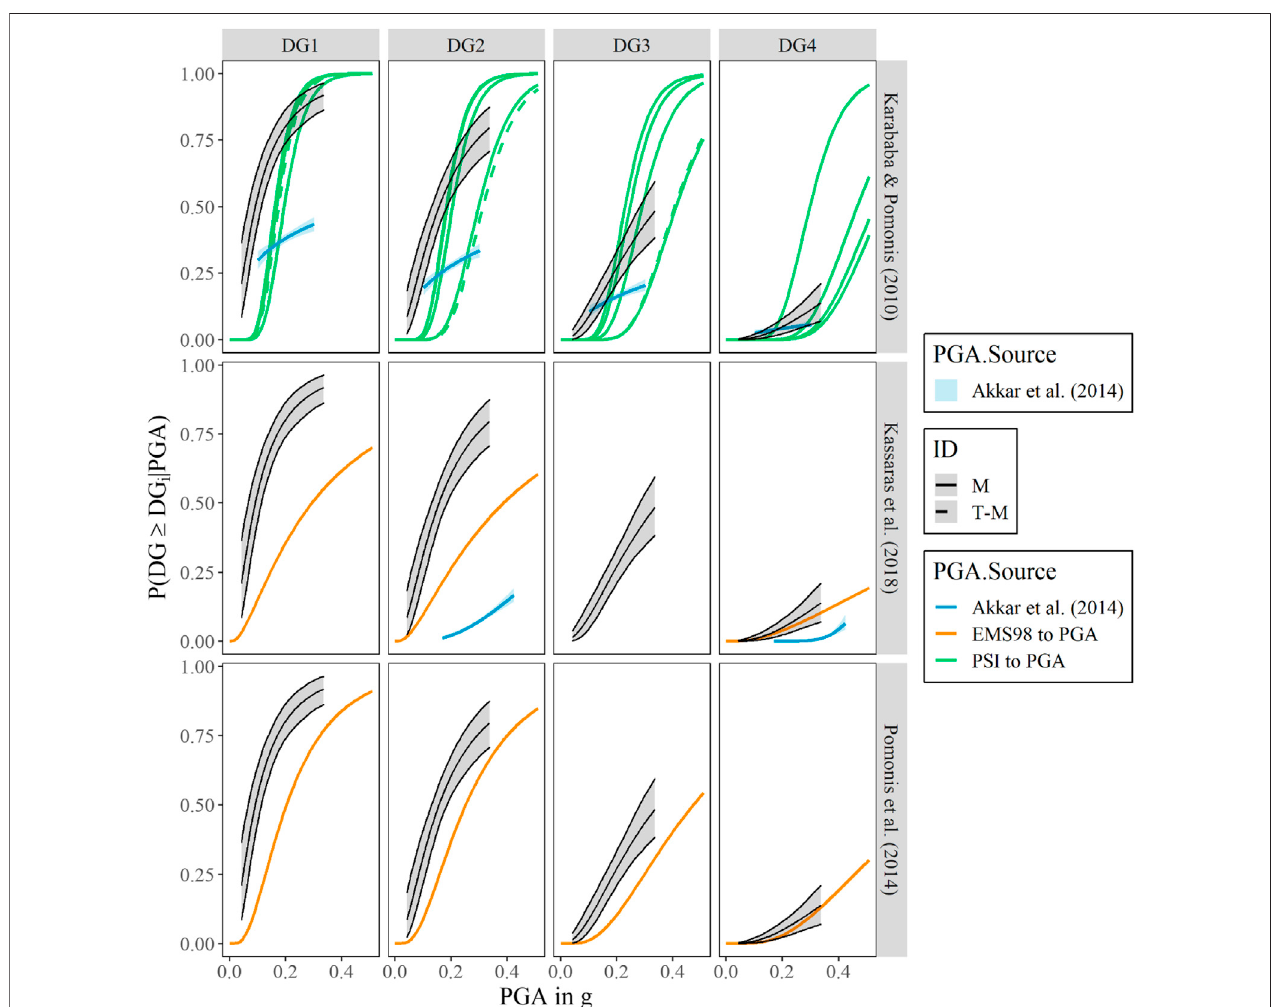
FIGURE 11 | Comparison of fragility curves constructed here (in black thicker lines) with existing fragility curves.